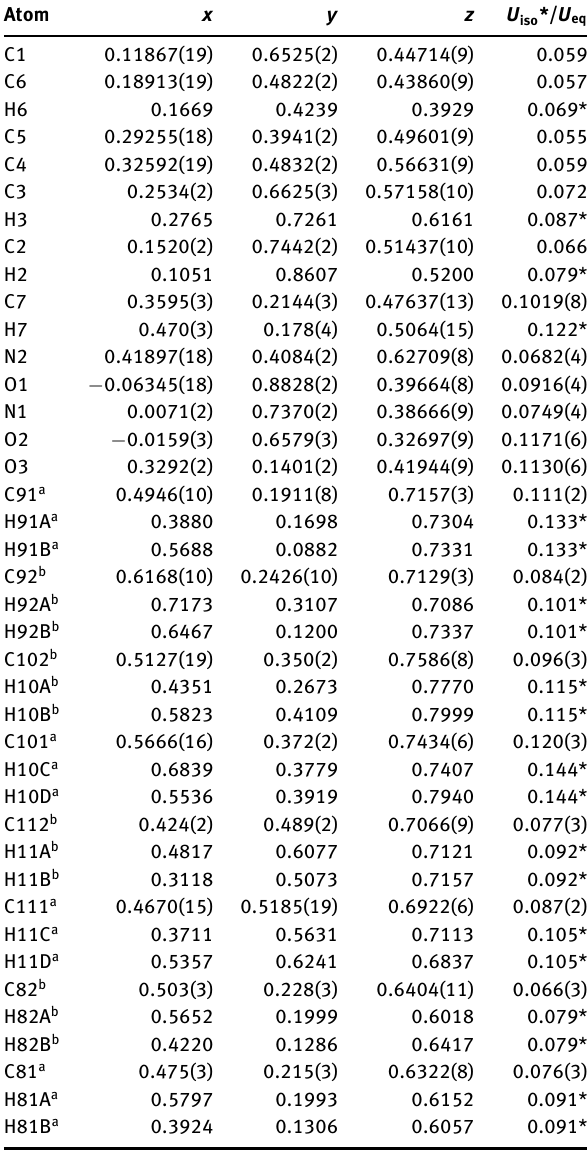
Table 2: Fractional atomic coordinates and isotropic or equivalent isotropic displacement parameters (Å 2 ).